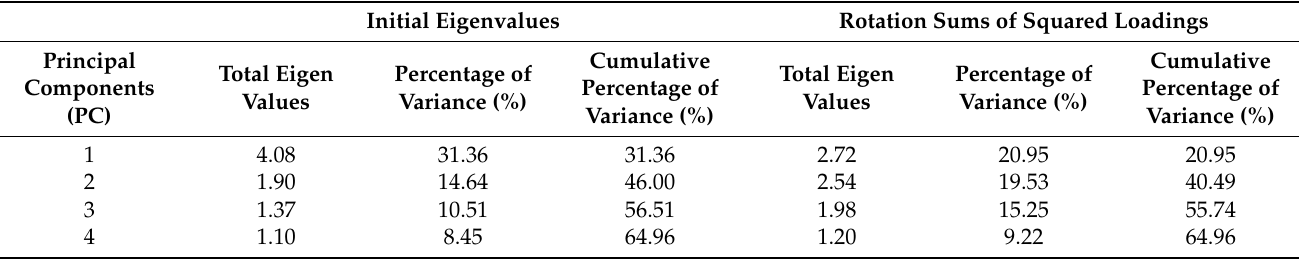
Table 3. Initial eigenvalues, rotation sums of squared loadings of the PCs, and percentage of variance explained.